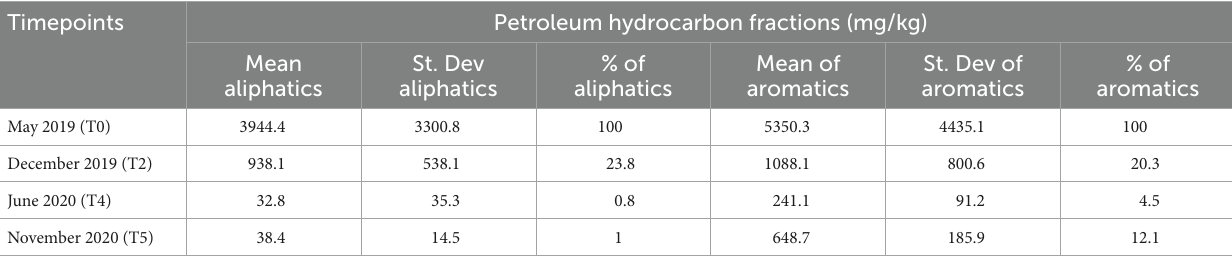
TABLE 1 Mean, standard deviation, and percentage against the initial quantity of the petroleum hydrocarbons present in the Ecopiles along the bioremediation